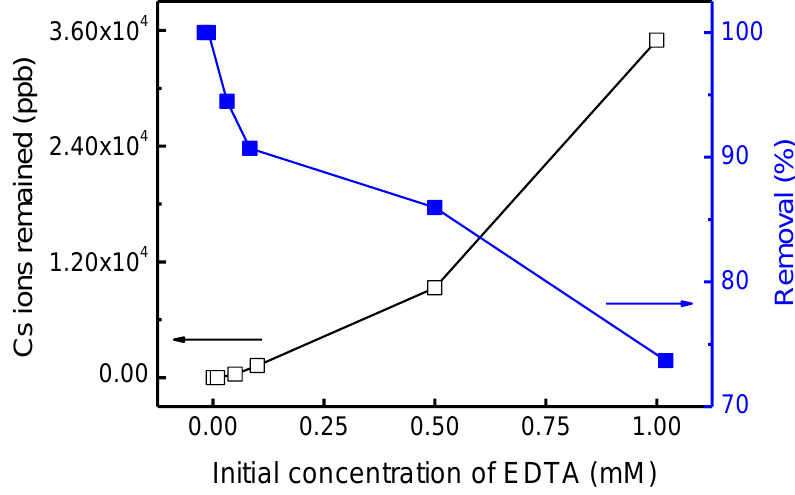
Figure 10. Removal efficiency of Cs ions with EDTA by AERs from EDTA/Cs (1:1) containing various initial EDTA concentrations. [AERs] = 2 g/L; pH = 7; adsorption time = 5 h.